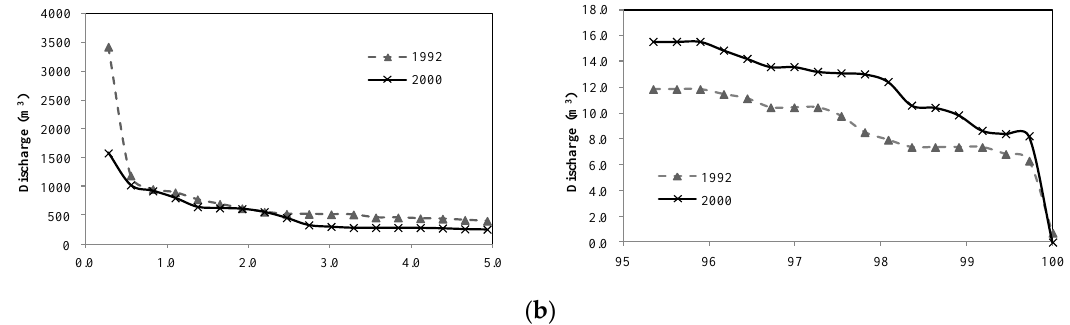
Figure 9. Flow duration curves (FDCs) for the selected pairs: ( a ) 1992 vs. 1995; and ( b ) 1992 vs. 2000. Table 7. Statistical tests for the effect of forest disturbances on the low flows and high flows .